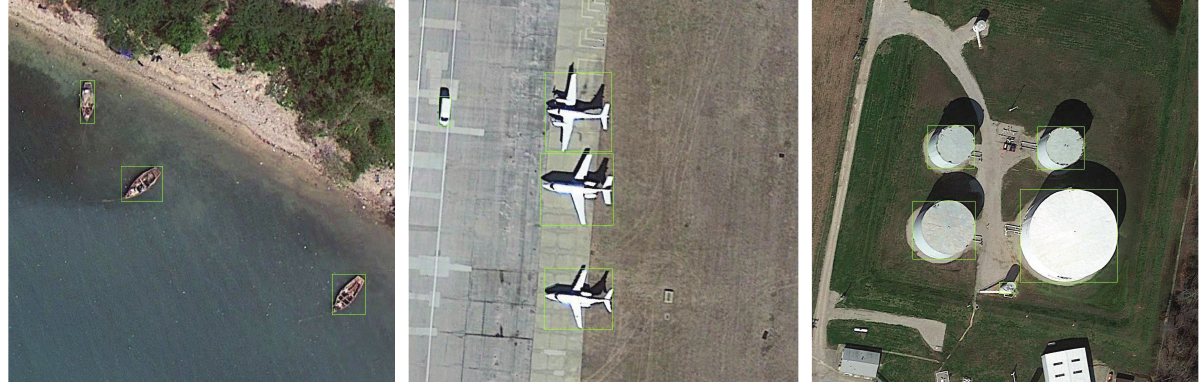
Figure 6. Images of the object DetectIon in Optical Remote sensing images (DIOR) dataset.